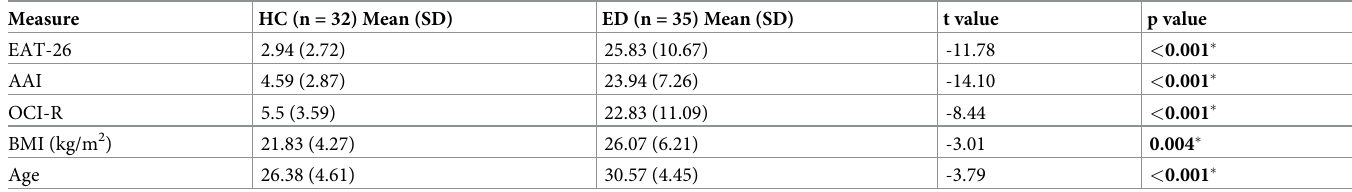
This includes means and standard deviations (SD) of EAT-26, AAI, OCI-R scores, age, and BMI, as well as t- and p- values of the two-sample t-tests. � —significance at the